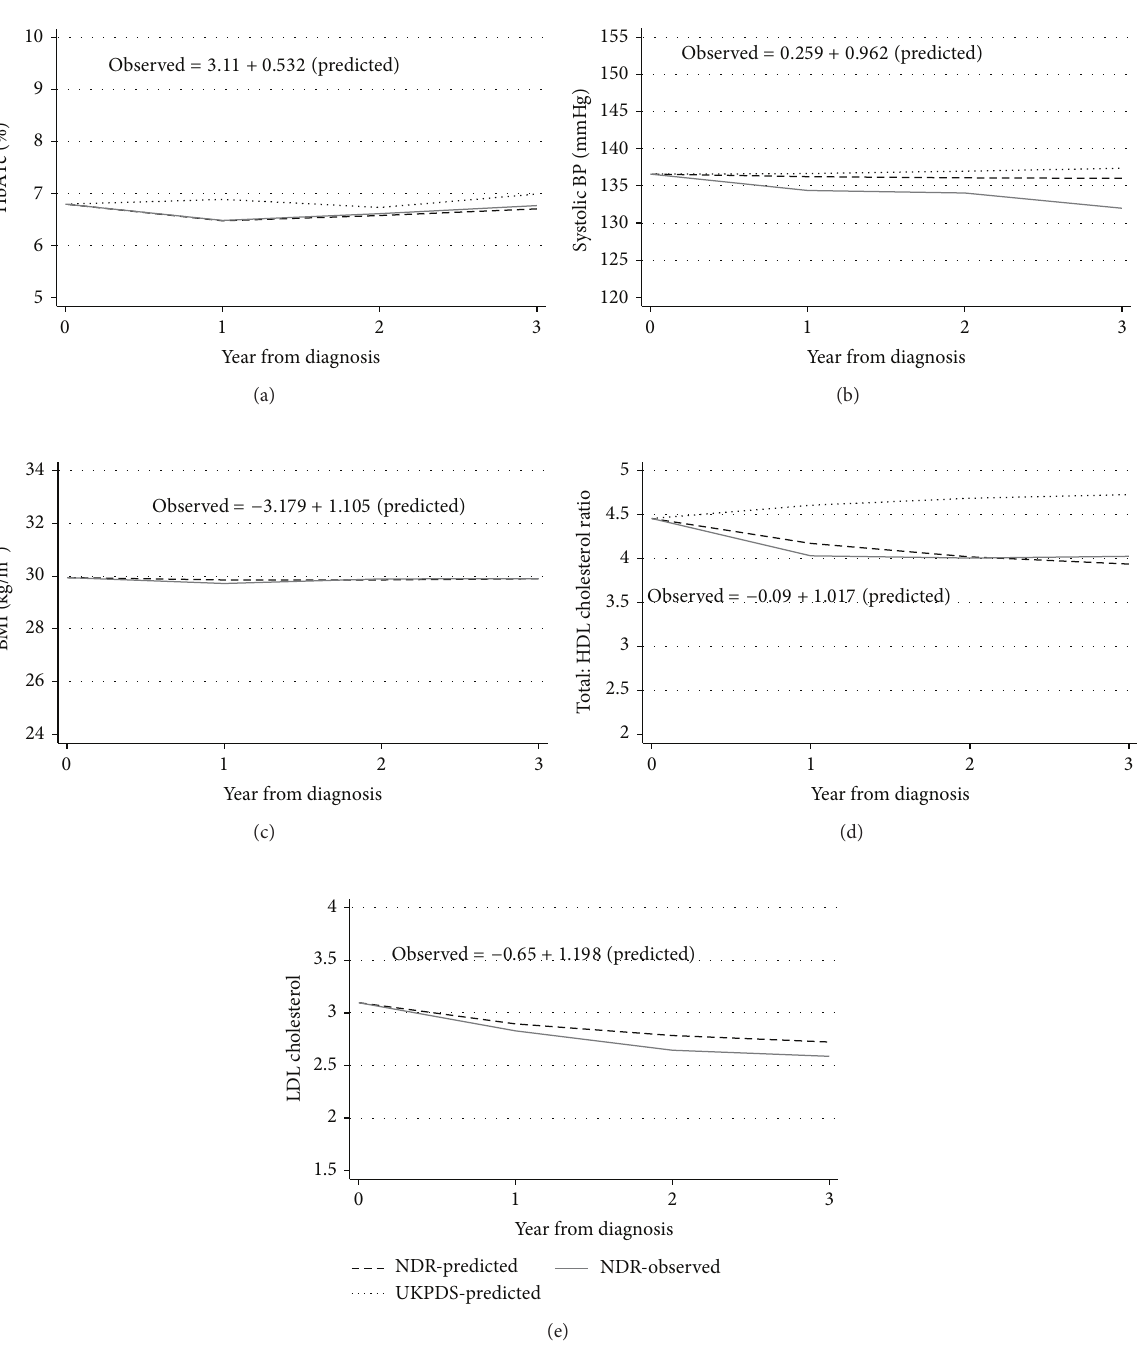
; (b) systolic BP; (c) BMI; (d) TC:HDL; and (e) LDL c